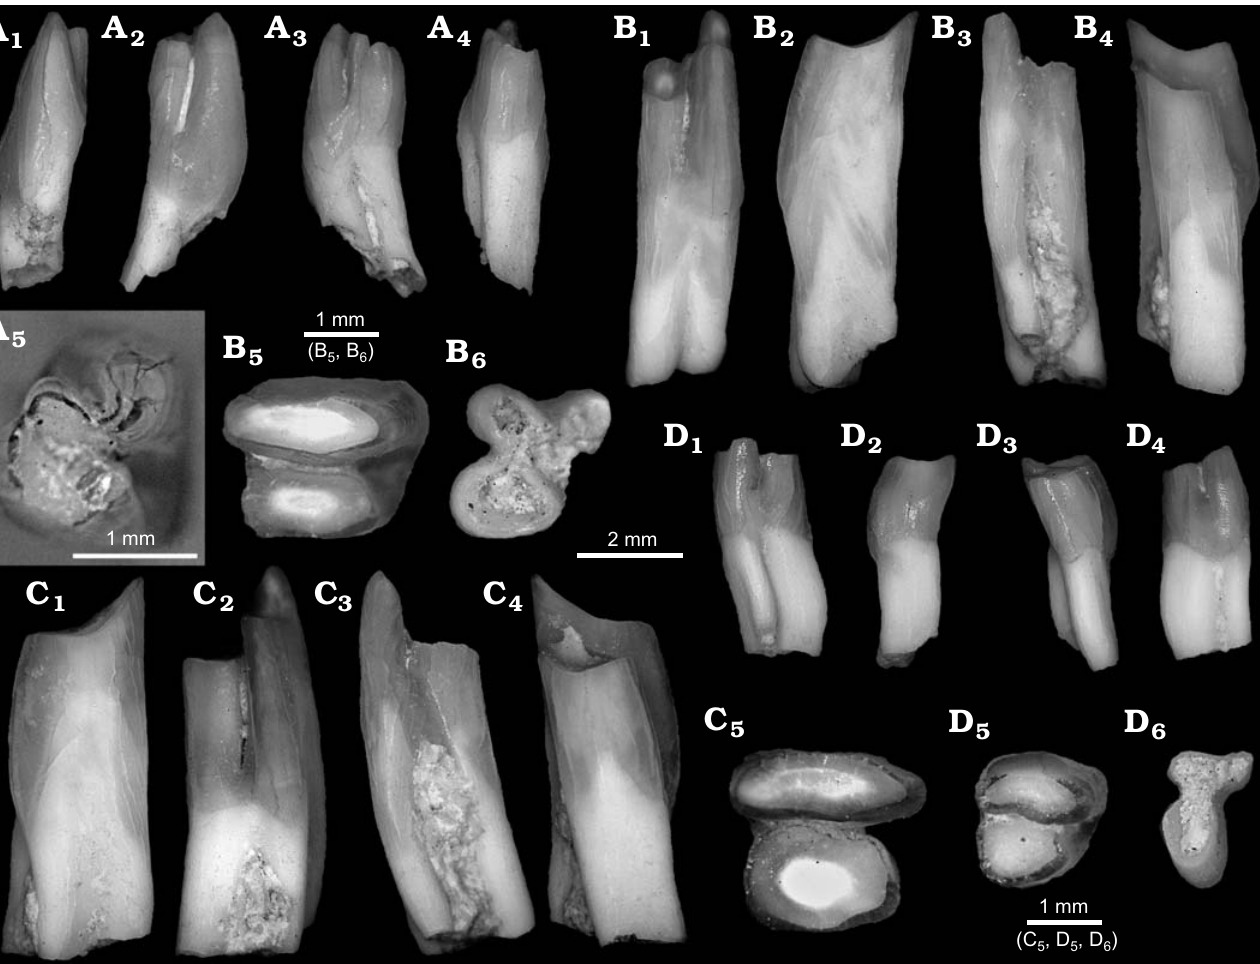
Fig. 10. Lower cheek dentition of the lagomorph Gobiolagus aliwusuensis Fostowicz-Frelik, Li, Meng, and Wang, 2012 from the Eocene of Wulanhuxiu, Nei Mongol, China. A . Right p3 (IVPP V20265.13) in anterior (A 1 ), buccal (A 2 ), lingual (A 3 ), posterior (A 4 ), and occlusal (A 5 ) views. B . Right m1 (IVPP V20265.14) in buccal (B 1 ), anterior (B 2 ), lingual (B 3 ), posterior (B 4 ), occlusal (B 5 ), and apical (B 6 ) views. C . Right m2 (IVPP V20265.16) in anterior (C 1 ), buccal (C 2 ), lingual (C 3 ), posterior (C 4 ), and occlusal (C 5 ) views. D . Right m3 (IVPP V20265.17) in lingual (D 1 ), anterior (D 2 ), posterior (D 3 ),